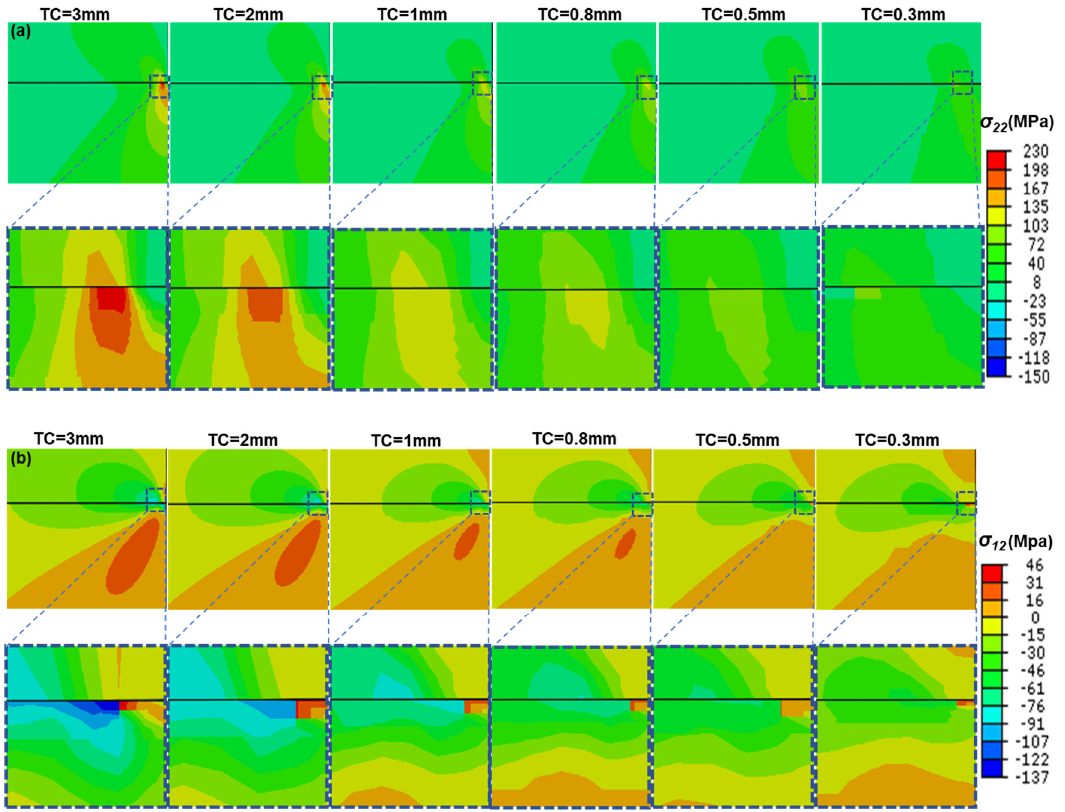
Figure 3. Variation of stress field: ( a ) σ 22 and ( b ) σ 12 at crack tip with different TC thickness.